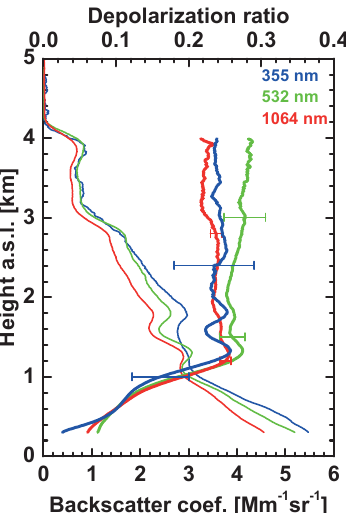
Figure 7. Triple-wavelength particle depolarization ratio profiling on 20 June 2014 during SALTRACE-3. Mean profiles of the parti- cle backscatter coefficient (thin lines) and the particle linear depo- larization ratio (thick lines) at 355nm (blue), 532nm (green), and 1064nm (red) wavelength are shown. All signals of the 3h period in Fig. 5 are averaged and vertically smoothed with 200m window length except in the case of the 355nm depolarization ratio above 2.4km height. Here, the signal smoothing length is 750m (from 2.4 to 3.2m height) and 1200m (3.2–4.0km height). Error bars indi- cate retrieval uncertainties in the depolarization ratio values (Haarig et al., 2017a). Relative errors of the particle backscatter coefficients are on the order of 5–10%.